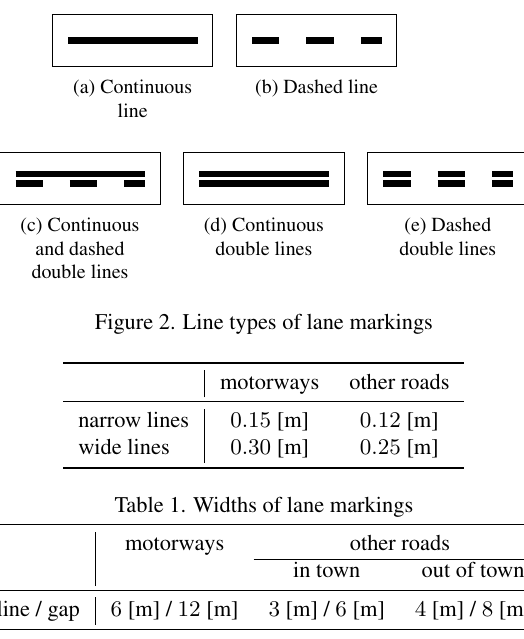
Table 2. Lengths of dashed lane markings with ratio